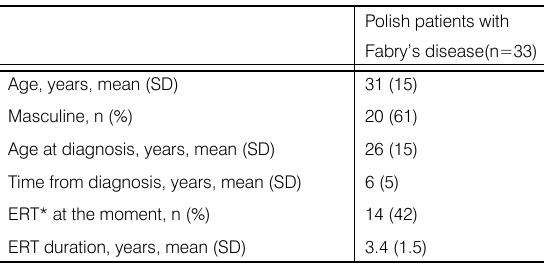
Figure 1. Comparison of EQ-VAS scores in Polish adult Fabry male ( ) and female ( ) patients with age and gender matched Polish normative data ( )